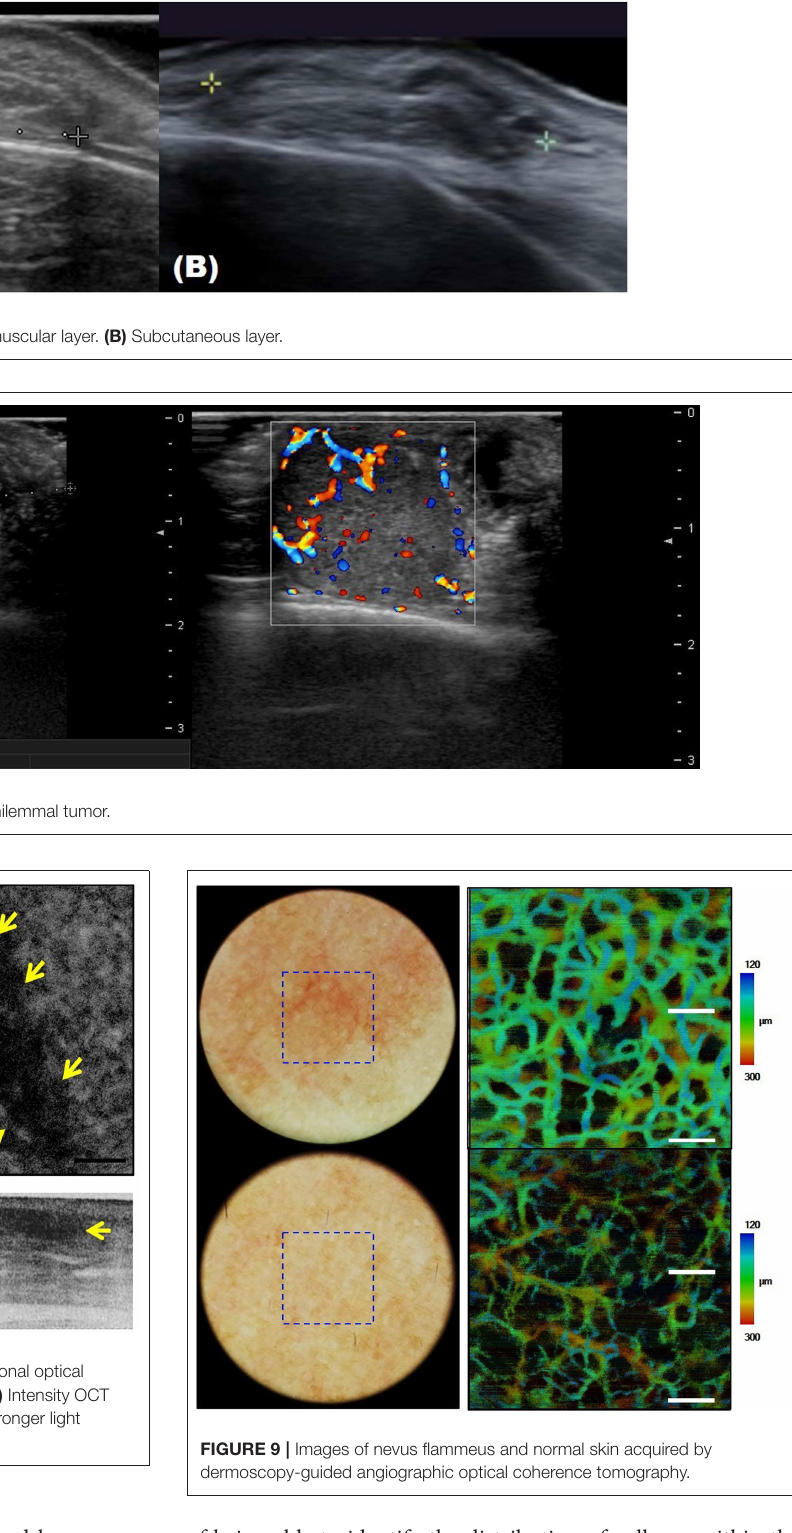
absorbing two photons with long wavelengths and low energy.